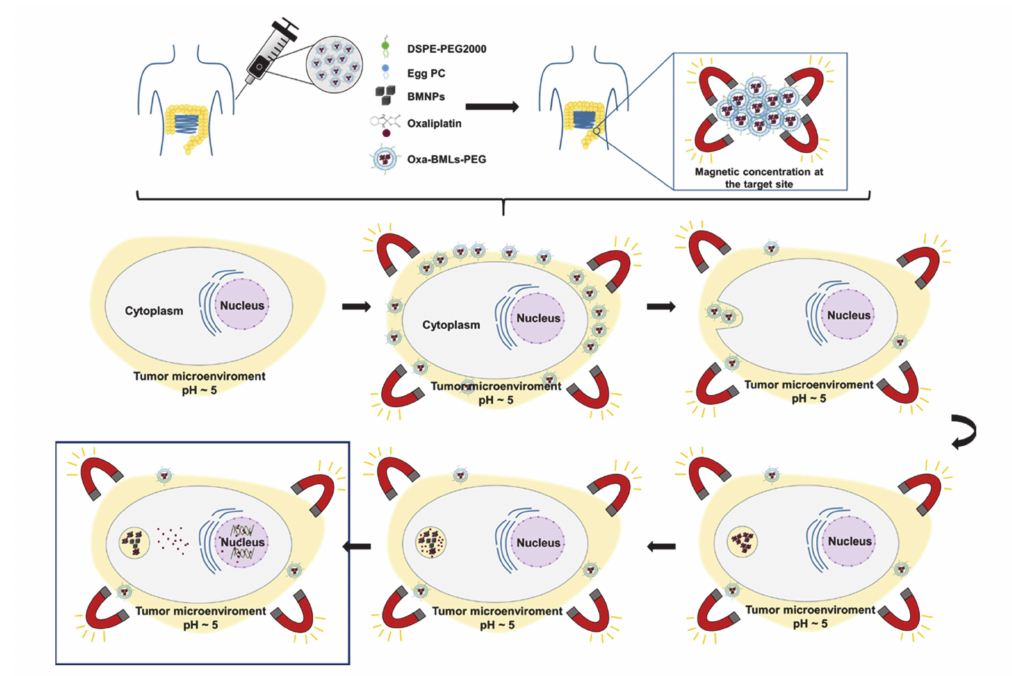
Figure 9. Proposed model of the di ff erent mechanisms of action of Oxa-BMLs-PEG in cancer